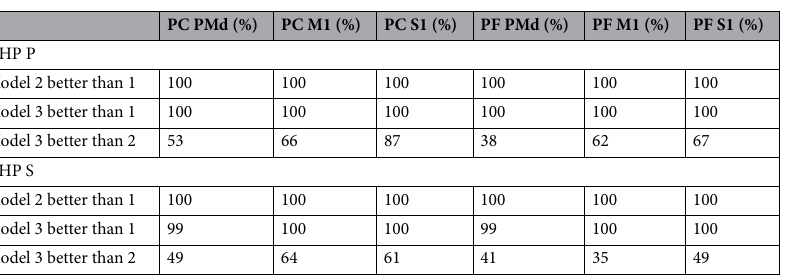
Table 3. Percentage of all recorded units with better adjusted R-squared for a given model comparison. PC = post cue, PF = post